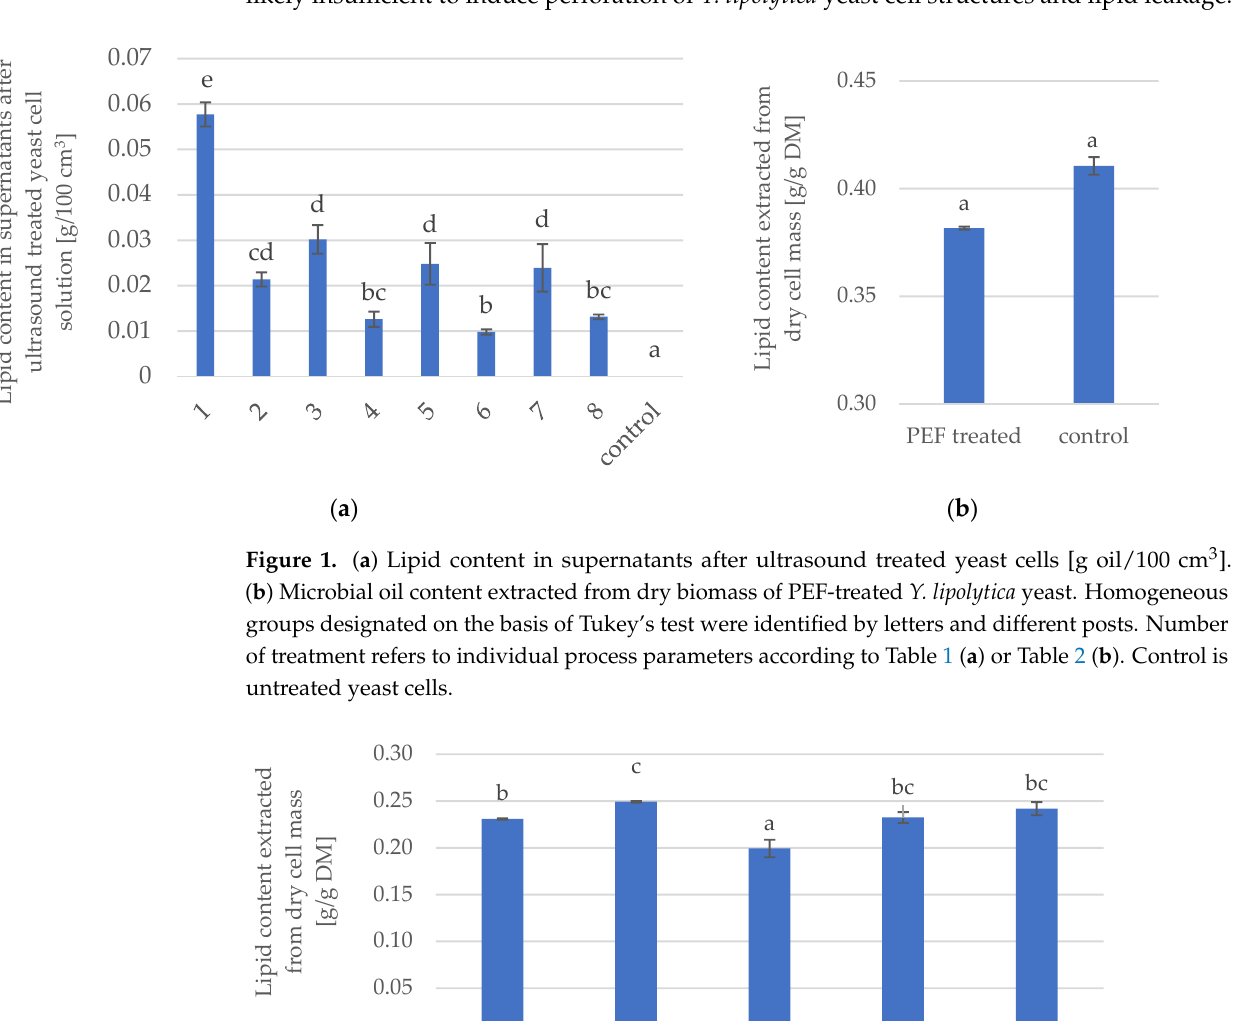
Figure 1. ( a ) Lipid content in supernatants after ultrasound treated yeast cells [g oil/100 cm 3 ]. ( b ) Microbial oil content extracted from dry biomass of PEF-treated Y. lipolytica yeast. Homogeneous groups designated on the basis of Tukey’s test were identified by letters and different posts. Number of treatment refers to individual process parameters according to Table 1 ( a ) or Table 2 ( b ). Control is untreated yeast cells.